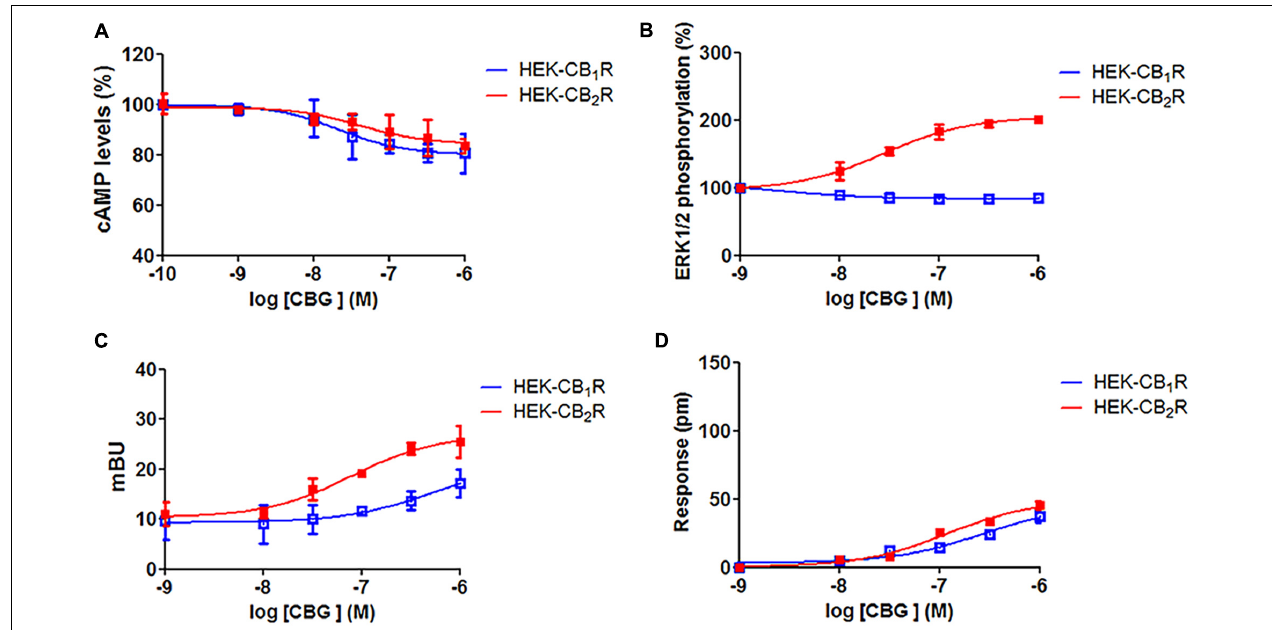
FIGURE 3 | Cannabigerol action in cells expressing CB 1 R or CB 2 R. HEK-293T cells were transfected with 0.75 µ g cDNA for CB 1 R (red line) or 1 µ g cDNA for CB 2 R (blue line). Dose–effect curves for cAMP production are expressed as % of levels obtained by 0.5 µ M forskolin treatment (A) . Dose-effect curves for ERK1/2 phosphorylation are expressed as % respect to basal levels (B) . Dose-effect curves for β -arrestin recruitment (C) and label-free (D) assays are expressed, respectively, in mBRET units and pm. In β -arrestin-2 recruitment assays cells were transfected with 1 µ g cDNA for β -arrestin-Rluc and either 0.75 µ g cDNA for CB 1 R-YFP or 1 µ g cDNA for CB 2 R-YFP. Data are the mean ± SEM of a representative experiment in triplicates ( n =